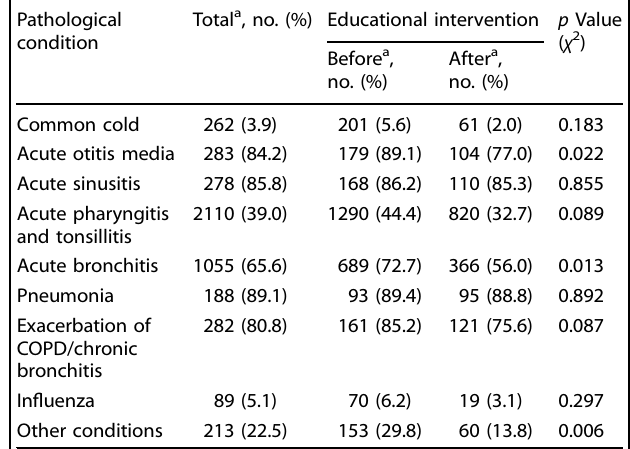
Table 3. Changes in the use of antibiotics in the different pathological conditions before and after the physician ’ s educational